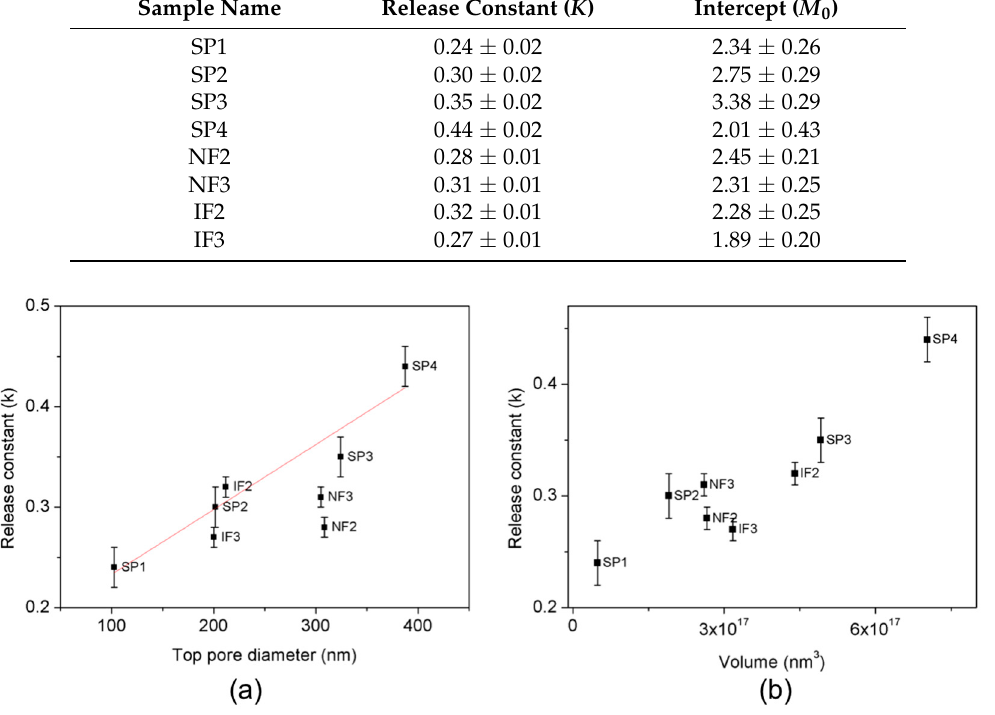
Figure 9. Release constant K during the short-term release versus ( a ) top pore diameter and, ( b ) volume. The red line corresponds to the linear fitting.